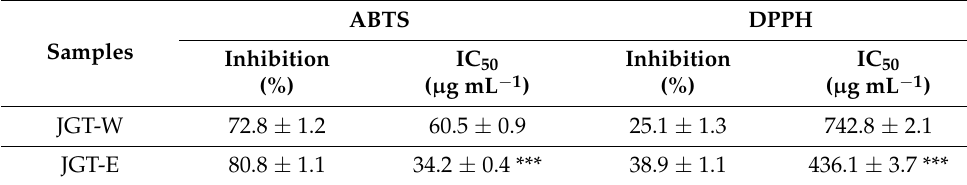
Table 2. Relative ABTS and DPPH activities of Jakyakgamcho-tang (JGT). Samples